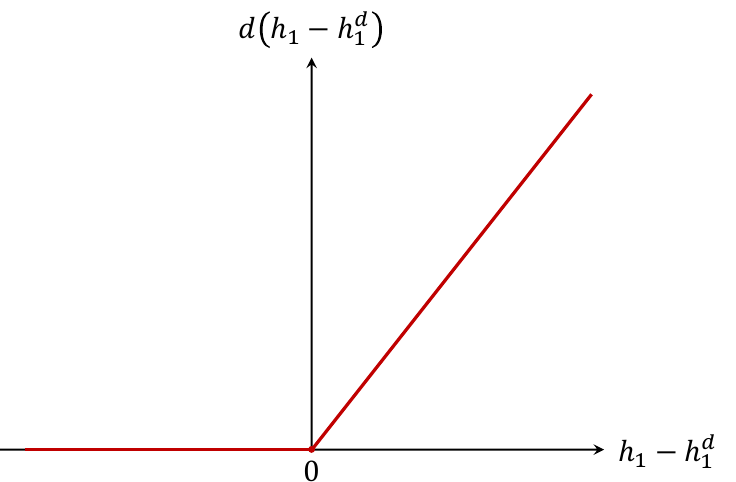
Figure 2. A piecewise linear climate damage function dependent on the difference between sea-level rise h 1 and the ‘efficient height’ of coastal protection h d